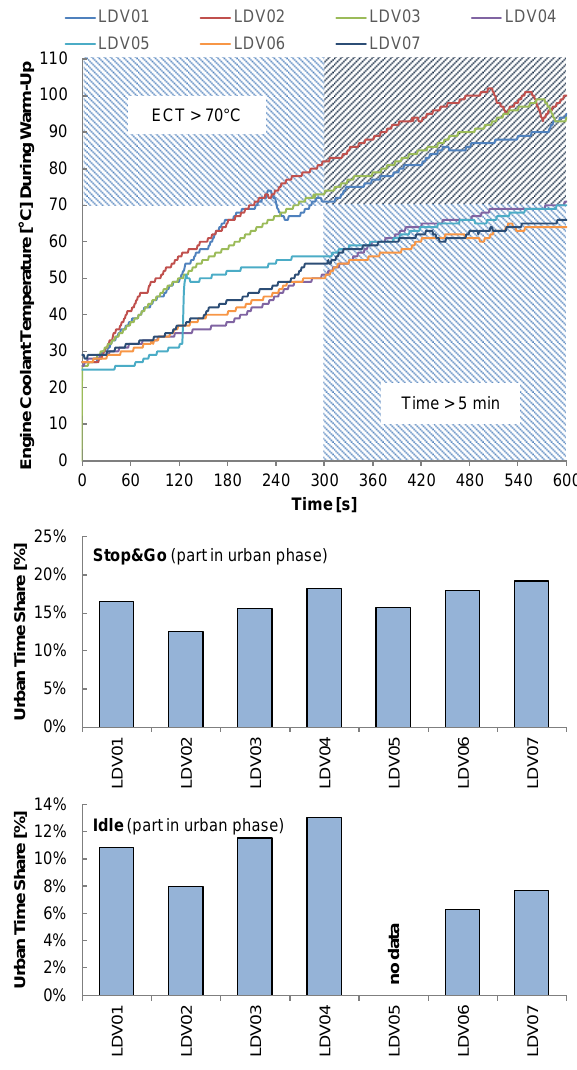
Fig. 5. Time courses of the engine coolant temperature during warm-up and time shares of stop&go and idling in the RDE-test